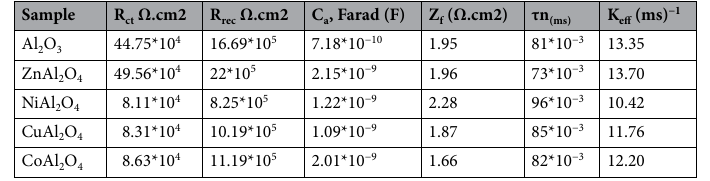
Table 2. Electrochemical Impedance of Al 2 O 3 NP s and MAl 2 O 4 with 6 cycles CdS/ZnS QD s as a photosensitizer.